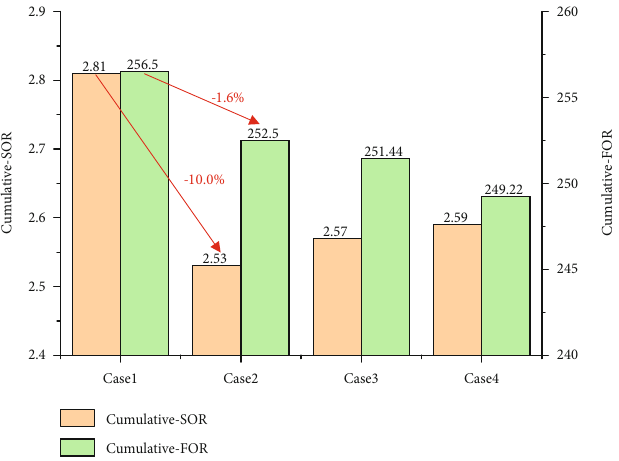
Figure 27: Cumulative SOR and cumulative FOR in di ff erent